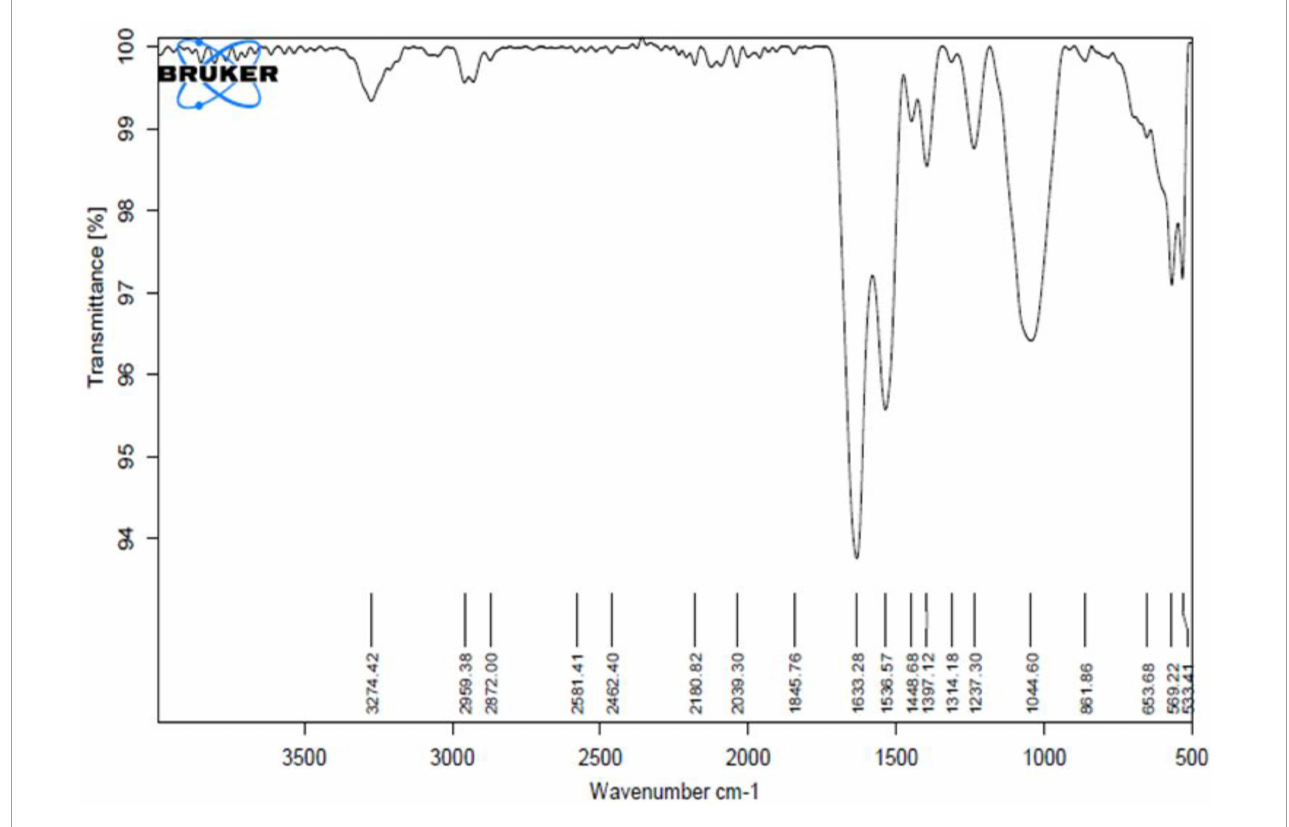
FIGURE6 FTIR spectra of BE produced by Parapedobacter